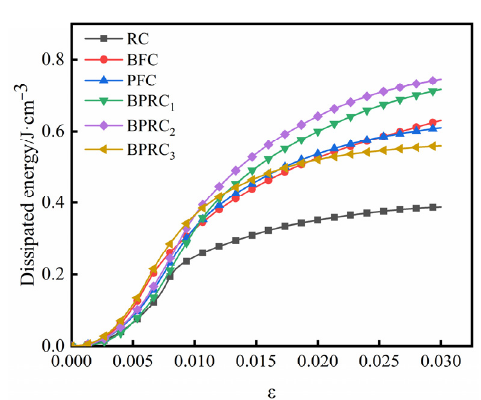
Figure 8. Dissipated energy.